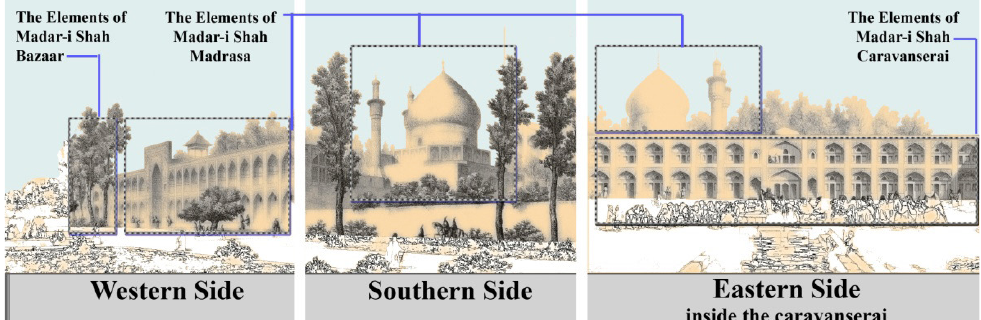
Figure 5. The structure of essences is manifested in Madar-i Shah Center (Adapted from Pascal Coste, Wikimedia)